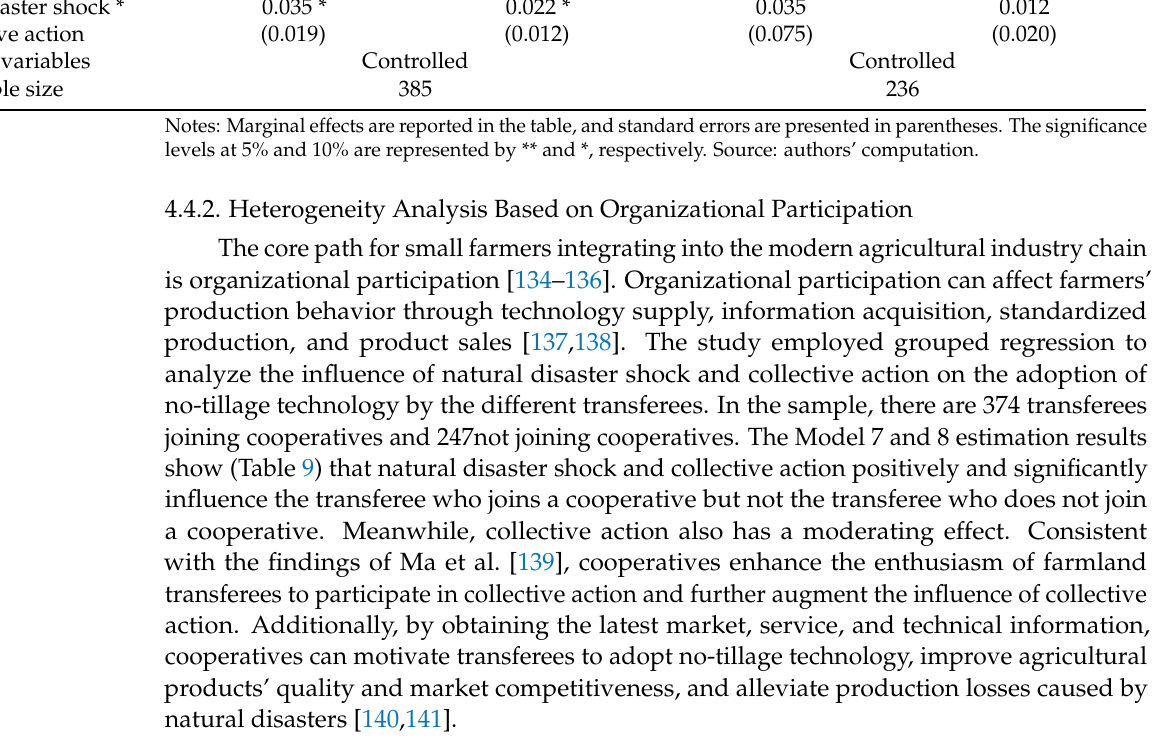
Table 9. Model estimation based on organizational-participation